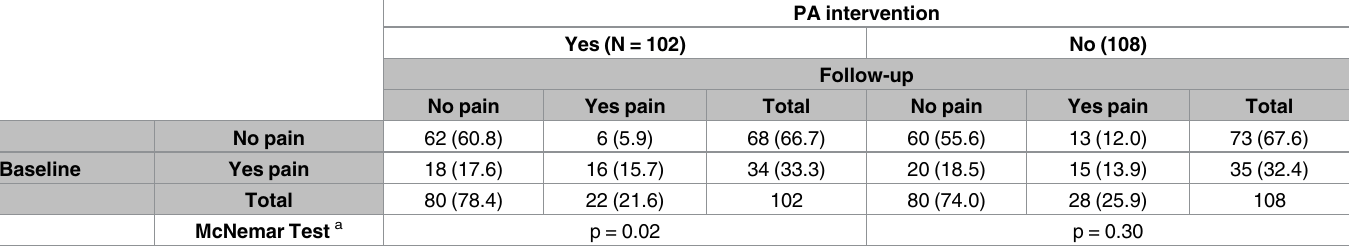
Table 3. Distribution, N (%), of low back pain presence(yes/no) at baseline and follow-up in the 210 study women according to physical activity (PA) intervention.